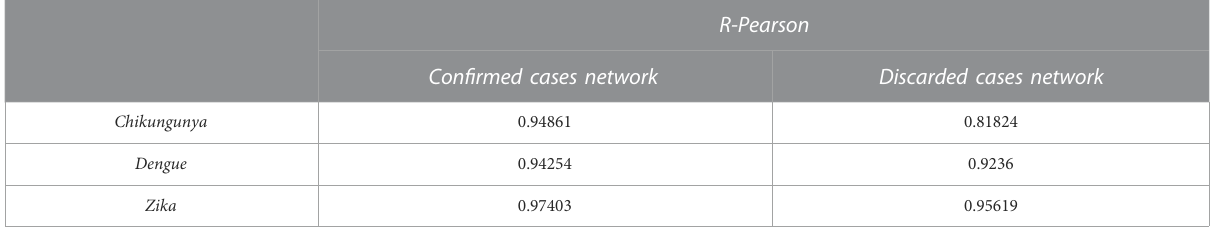
TABLE 1 Pearson correlation coef fi cient (R-Pearson) values for all panels in Figure